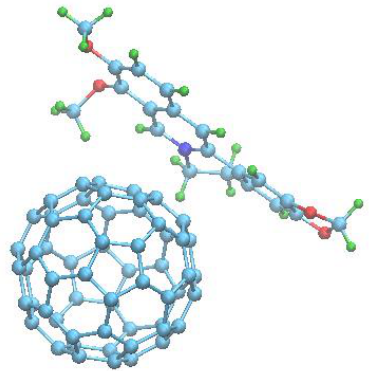
Figure 6. The energy-minimized structure of 1:1 C 60 -Ber nanocomplex.